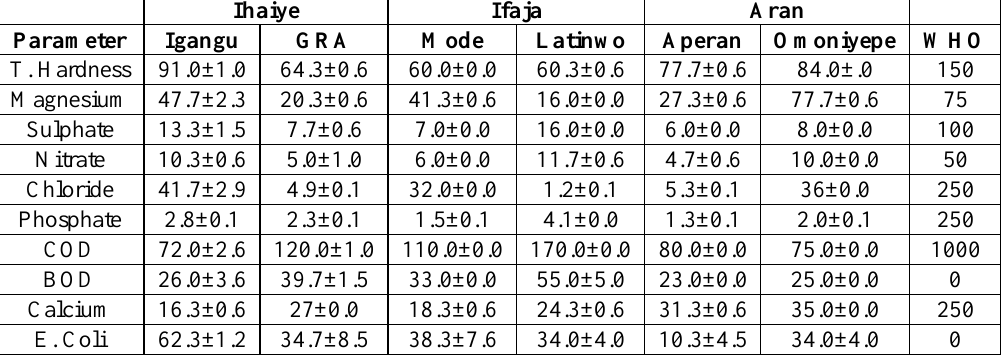
Table 3: Chemical analysis of some water samples collected from the sampling